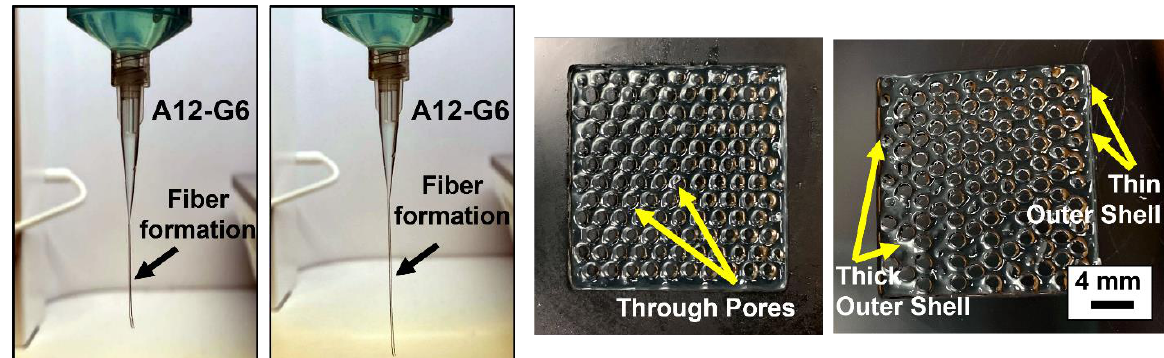
Figure 2. Manual dispensing results of A12-G6 bioink and the corresponding scaffolds printed using the same composition. The scaffolds exhibited high structural and shape fidelity. Moreover, they exhibited high resolution with the formation of through and well-defined pores.